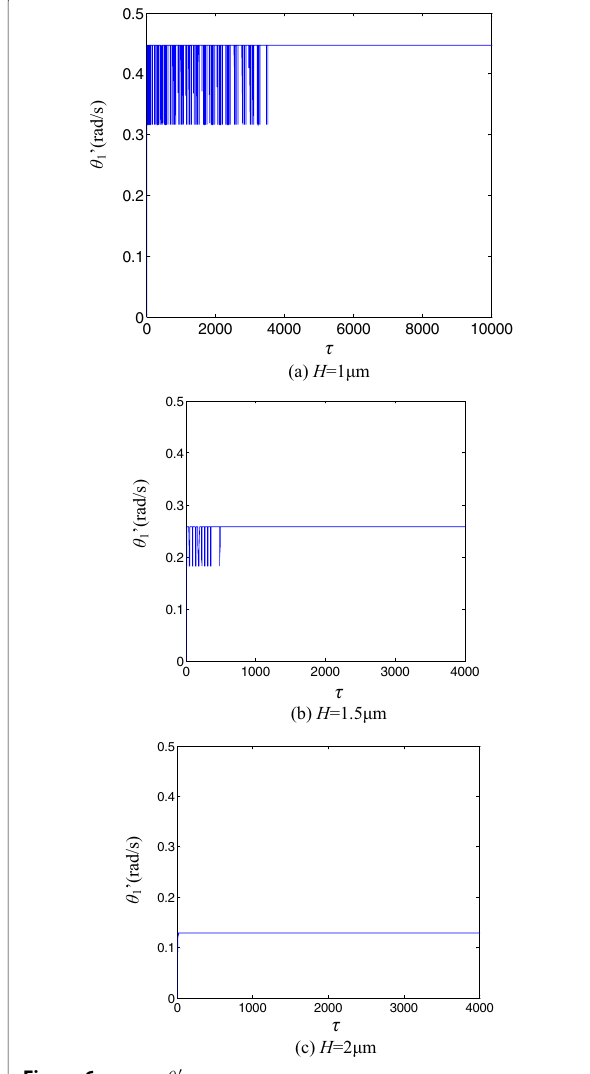
Figure 6 Change of θ ′ 1 under the different